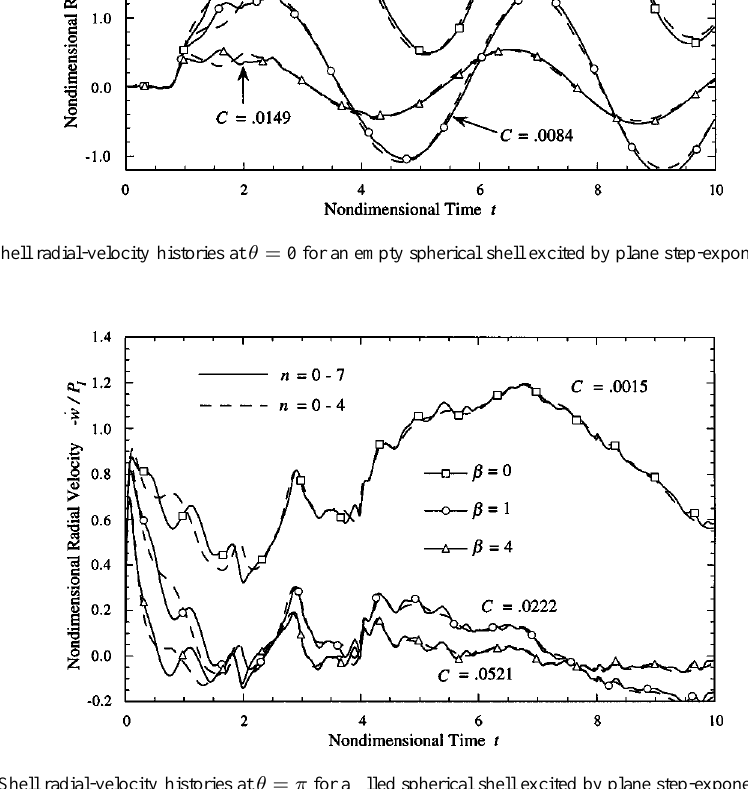
Fig. 6. Shell radial-velocity histories at (cid:18) = (cid:25) for a filled spherical shell excited by plane step-exponential waves.